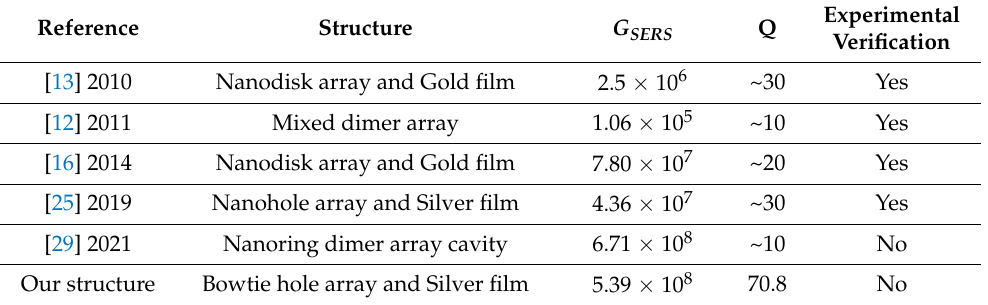
Table 2. Comparison of selective SERS enhancement substrates in previous works and our